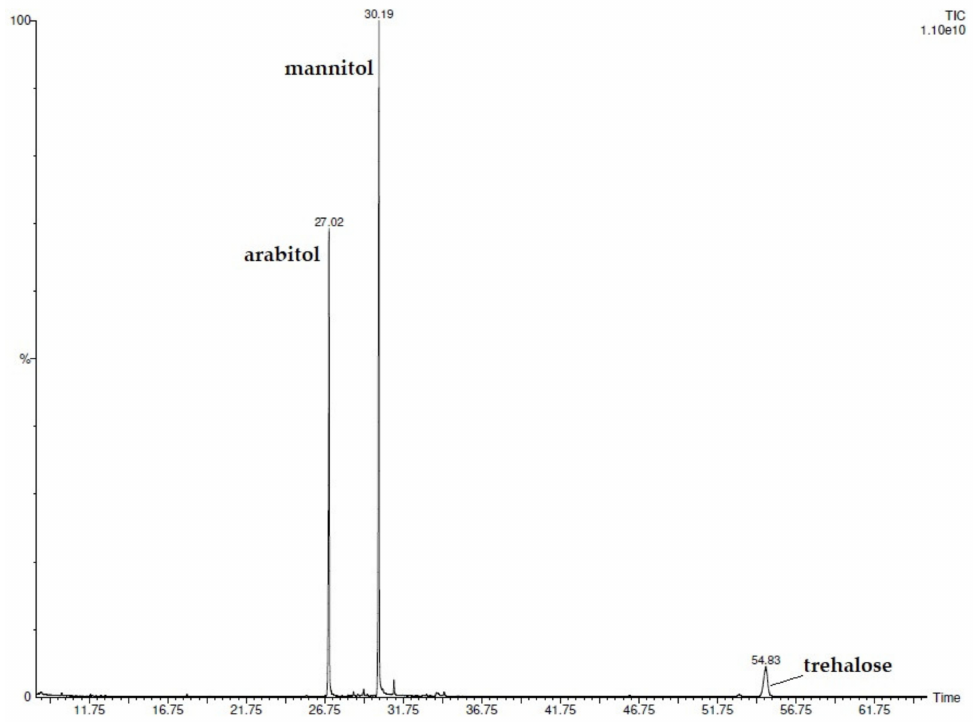
Figure 2. GC-FID chromatogram of L. maritima silylated ethanolic